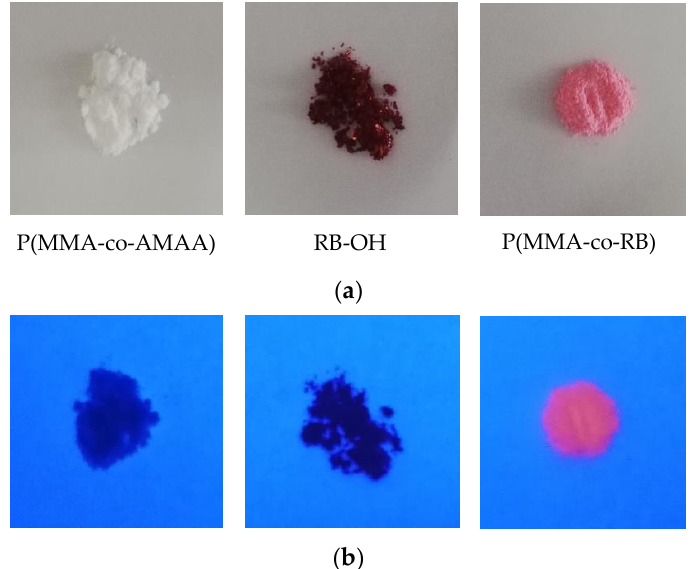
Figure 1. Photographs of P(MMA-co-AMAA), RB-OH and P(MMA-co-RB) under ( a ) visible light and ( b ) UV light at 365 nm.